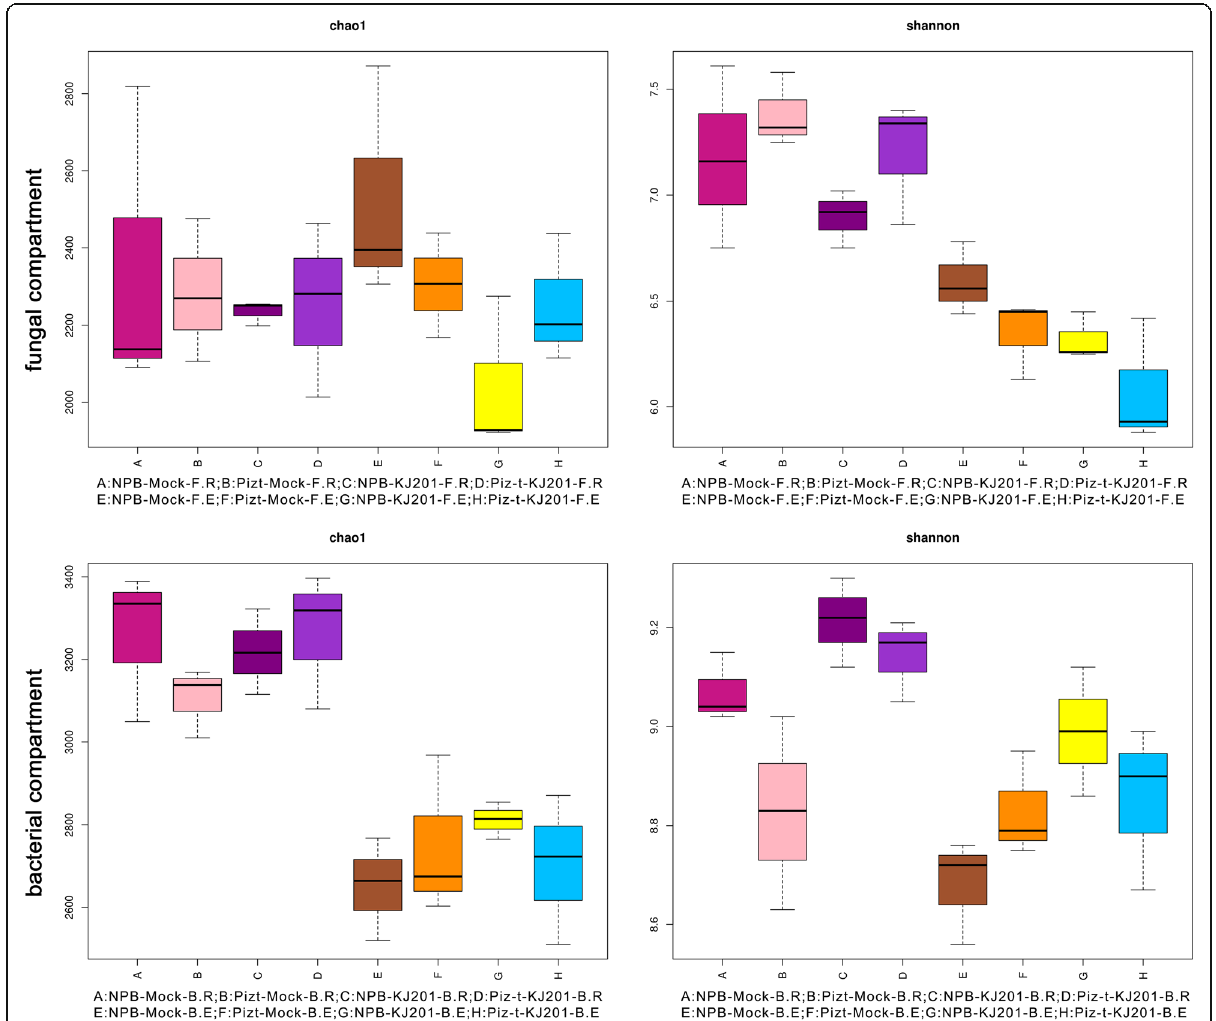
Fig. 3 Alpha diversity analysis (ANOVA with Tukey HSD test) of eight compartments from bacterial communities and fungal communities. Rhizosphere soils and root were collected for 16 s rRNA and ITS1 sequencing, respectively. Chao1 index and Shannon index for each of the trials as determined by Alpha diversity analysis are presented. The box contains five data nodes, and the upper edge, upper quartile, middle, lower quartile, and lower edges are calculated from a set of data arranged from large to small. The horizontal ordinate is the sample/grouping name and the ordinate is the Alpha Index. The difference was of no statistic significance between each